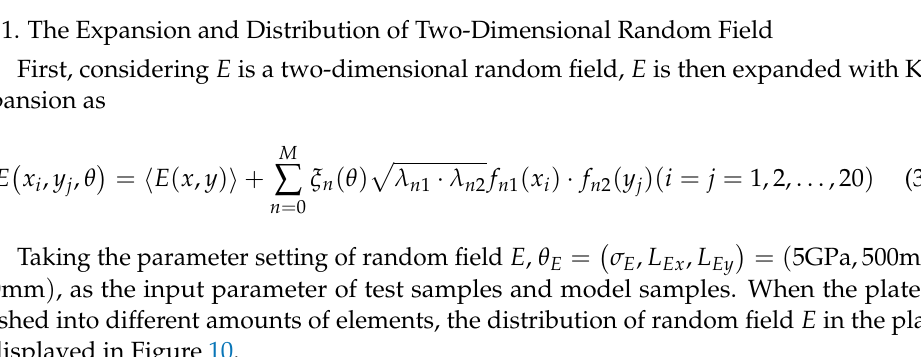
Figure 9. The plate fixed at one end ( left ) and its mesh elements ( right ).